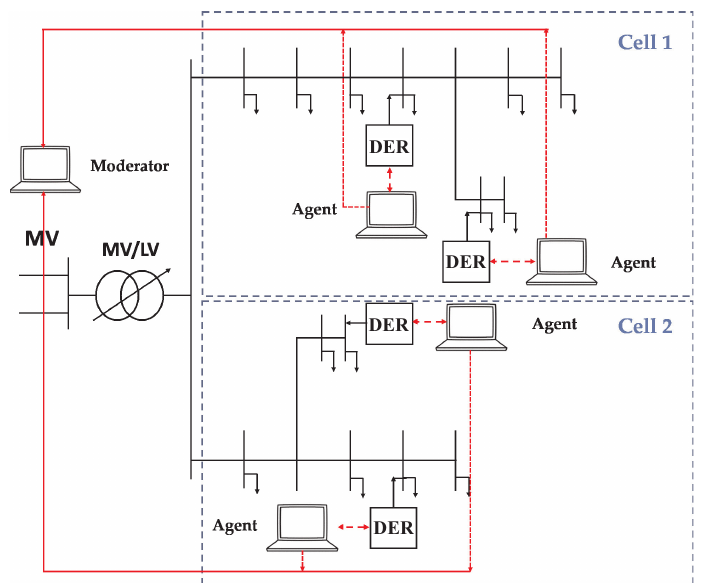
Figure 4. Layout of a DN with MAS control